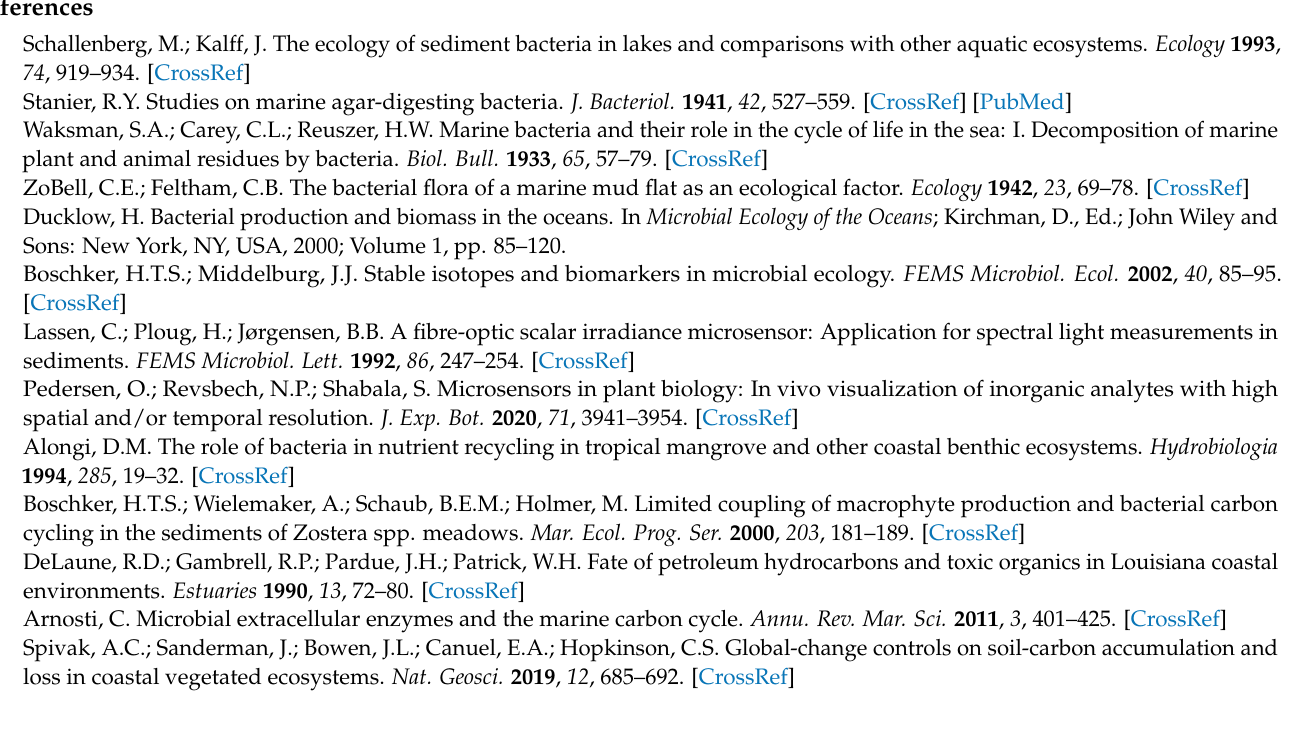
Figure S3: Trimming in silico analysis (341F-785R dataset to 515F-785R length); Table S1: